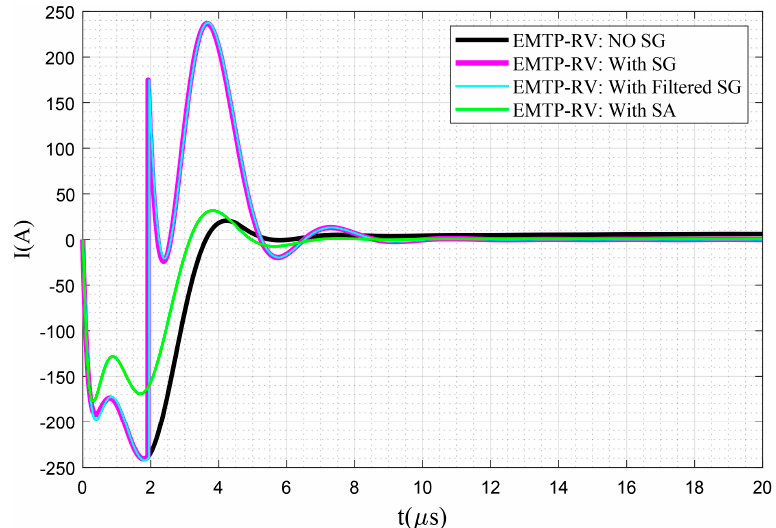
Figure 24. Comparison of the current flows after the connection points of the spark gap (SG) and surge arrester (SA).